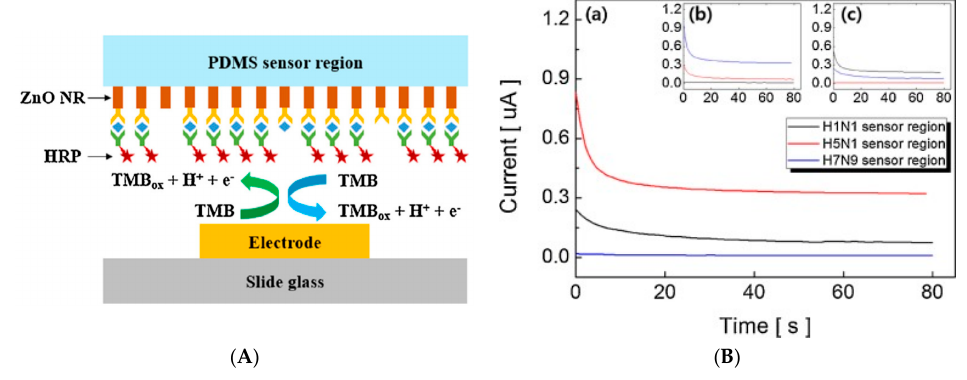
Figure 21. ( A ) Schematic representation of the structure of the ZnO nanorods microfluidic immunosensor for influenza virus detection; ( B ) Chronoamperometric curves measured from each electrode of the arrayed sensor, for an antigen mixture of ( a ) 1 pg mL − 1 H1N1 and 100 pg mL − 1 H5N1; ( b ) 10 pg mL − 1 H5N1 and 100 pg mL − 1 H7N9; and ( c ) 10 pg mL − 1 H1N1 and 1 pg mL − 1 H7N9, respectively. Reprinted from [113], Copyright 2016, with permission from Elsevier.